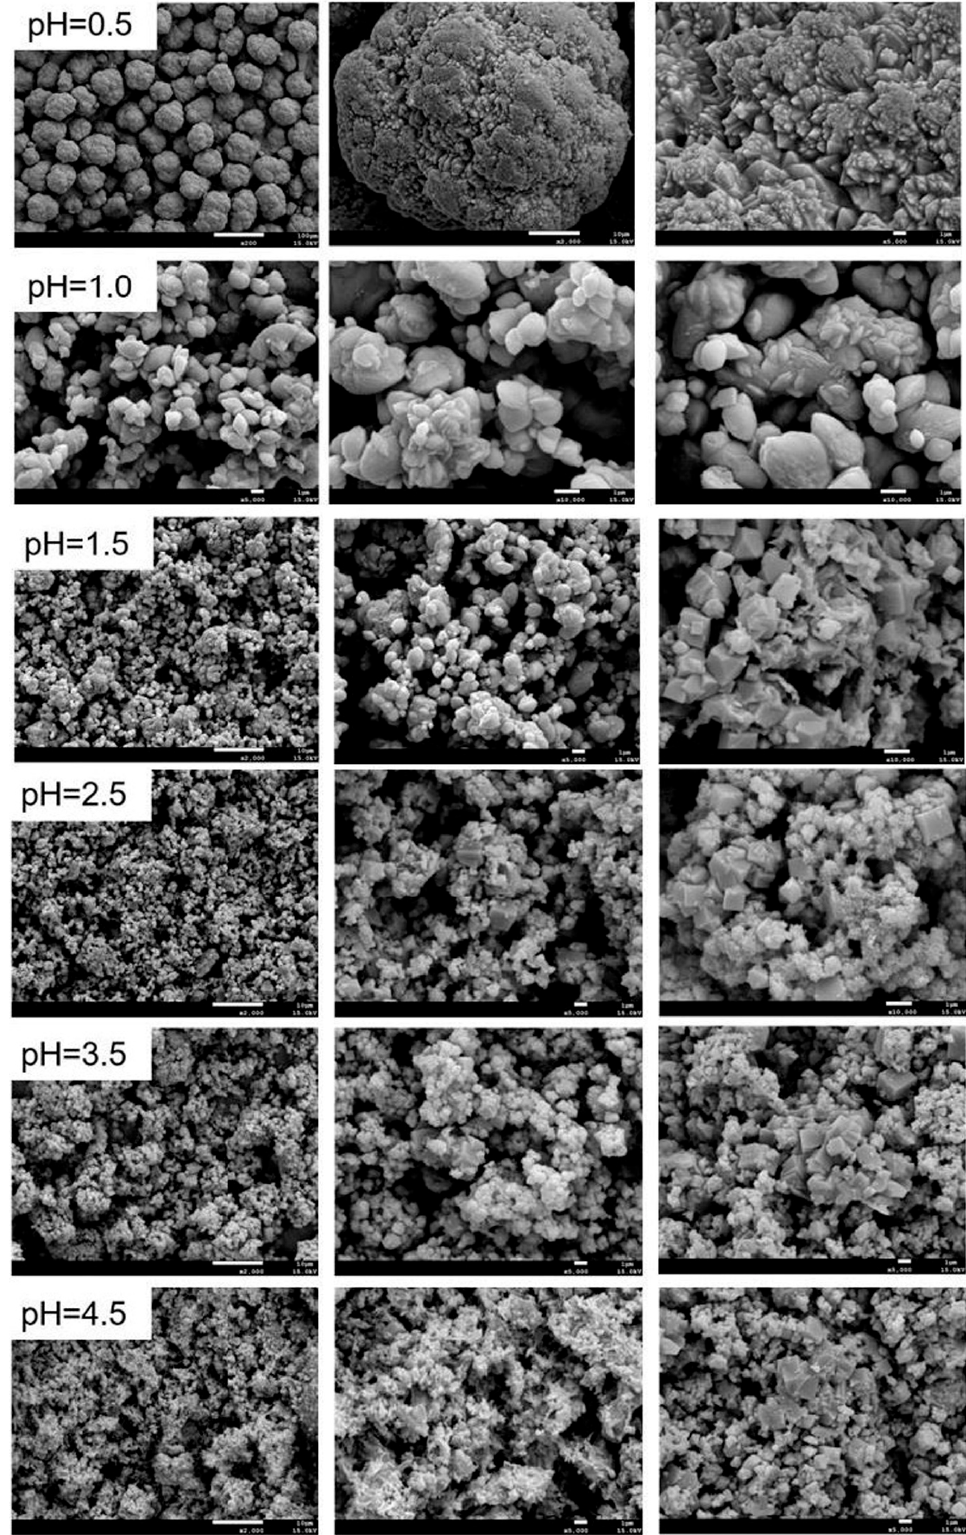
Figure 10. SEM analysis of precipitates obtained at different pH